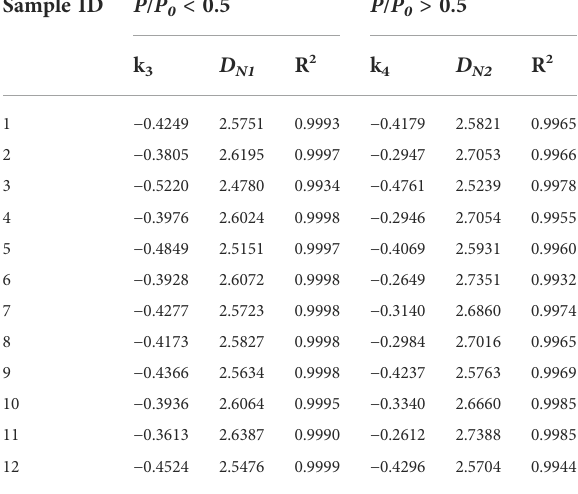
TABLE 3 Fractal dimension of N 2 adsorption isotherms in shale samples. Sample